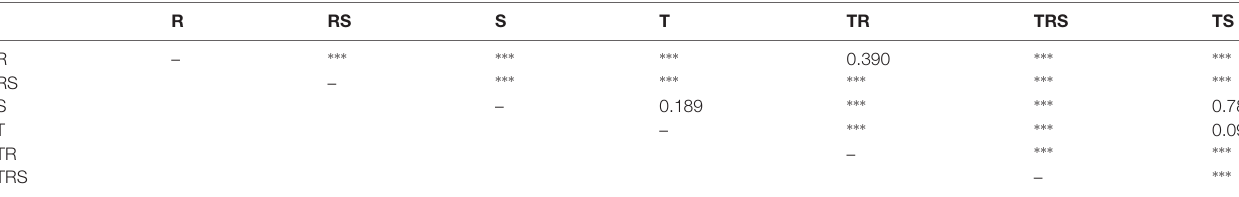
p-values below 0.001 are indicated by ∗∗∗ . Column and row labels refer to the kind of randomized transformation applied to the training data. R, Rotation only; S, Scaling only; T, Translation only; RS, Rotation and scaling; RT, Rotation and translation; TS, Translation and scaling; TRS, Translation, rotation and scaling.